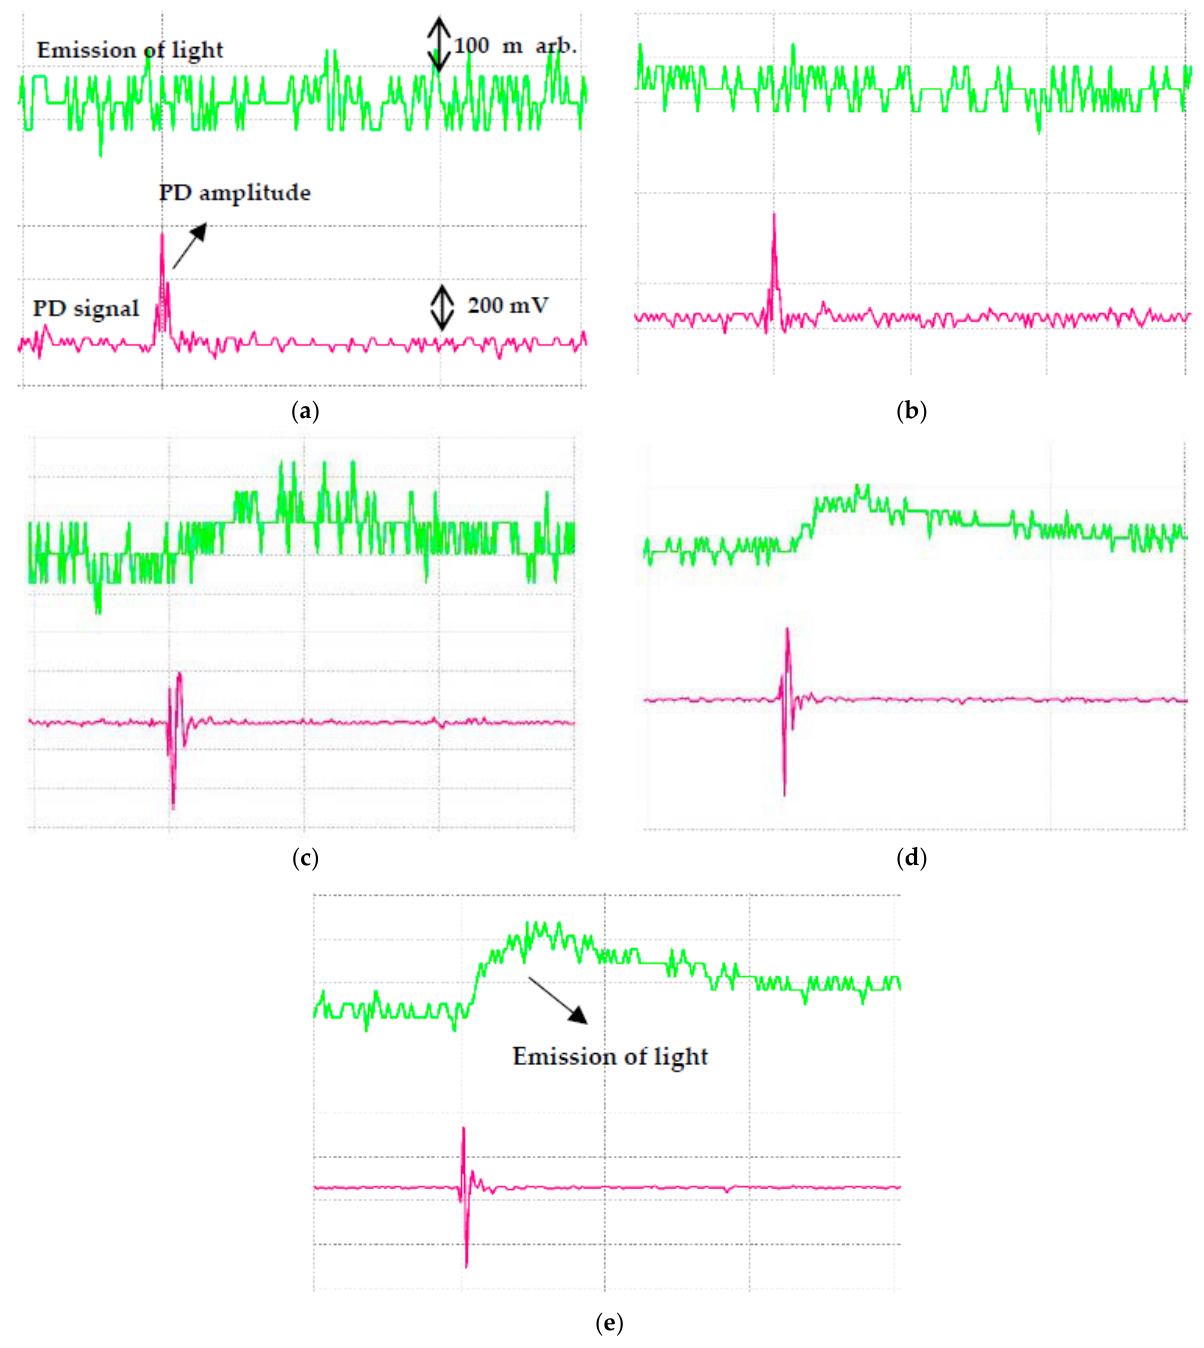
Figure 9. PD signal (IMC) and emission of light signals (PMT) for RBDPOA at ( a ) 10 kV, ( b ) 15 kV, ( c ) 20 kV, ( d ) 25 kV and ( e ) 30 kV applied voltage.